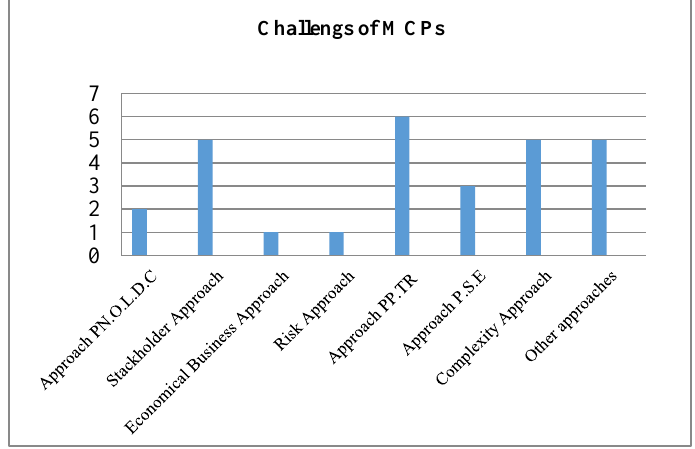
Figure 10. Degree of agreement among authors about the Challenges of MCPs depends on previous approaches.“Source: Authors”